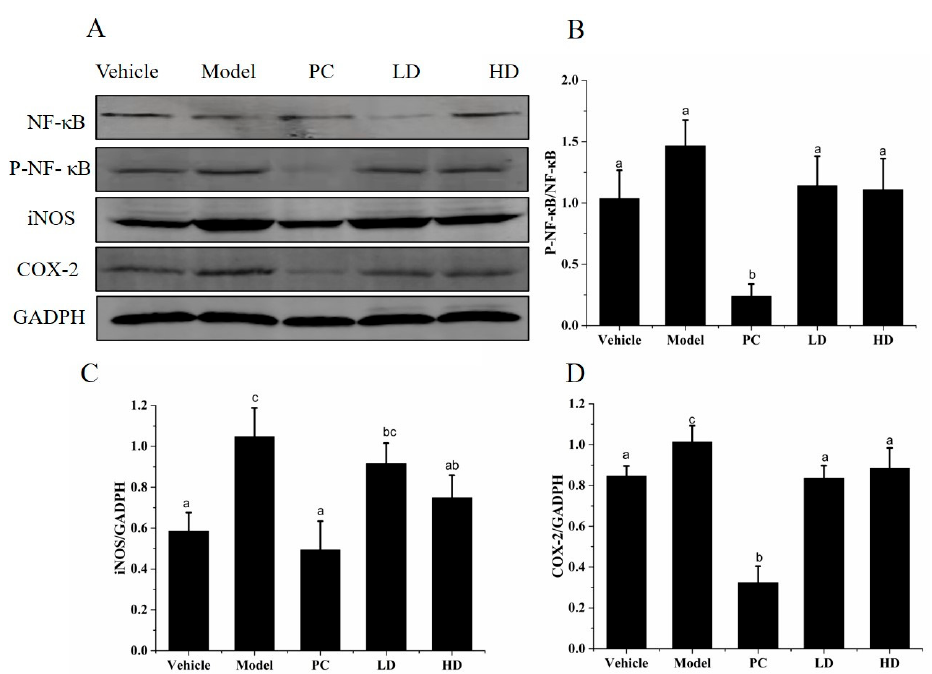
Figure 8. Effects of SAVEP on inflammatory protein expression in LPS-induced mice. ( A ) Expression levels of proteins were detected through Western blot analysis. ( B ) Quantitative analysis of P-NF- κ B/ NF- κ B protein level. ( C ) Quantitative analysis of iNOS protein level. ( D ) Quantification of COX-2 protein expression. Statistical analysis was performed using a one-way ANOVA with Tukey’s test. Data represent the mean ± SD ( n = 6). Different letters represent significant differences between groups ( p < 0.05).